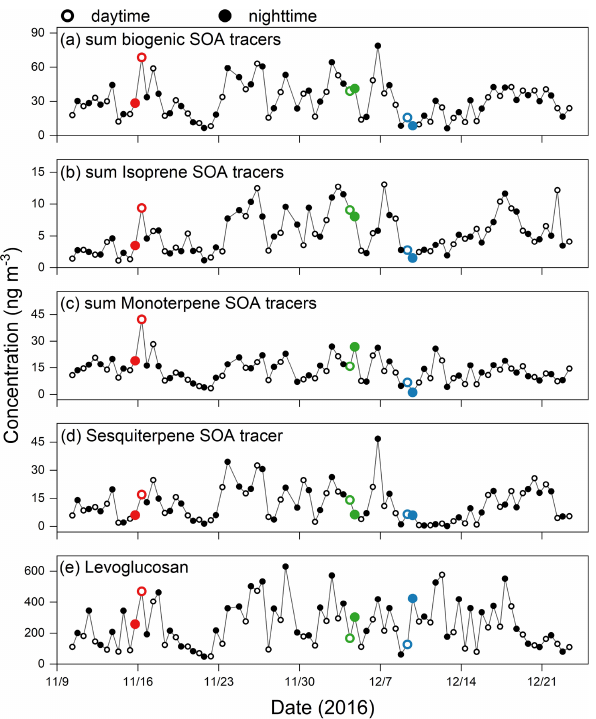
Figure 1. Temporal variations in the concentrations of biogenic SOA tracers and biomass-burning tracer detected in Tianjin PM 2 . 5 (Fan et al., 2020). (a) Sum of biogenic SOA tracers; (b) isoprene SOA tracers; (c) monoterpene SOA tracers; (d) β -caryophyllene SOA tracer. The red, green, and blue circles represent the PM 2 . 5 samples with high, moderate, and low SOA loading,